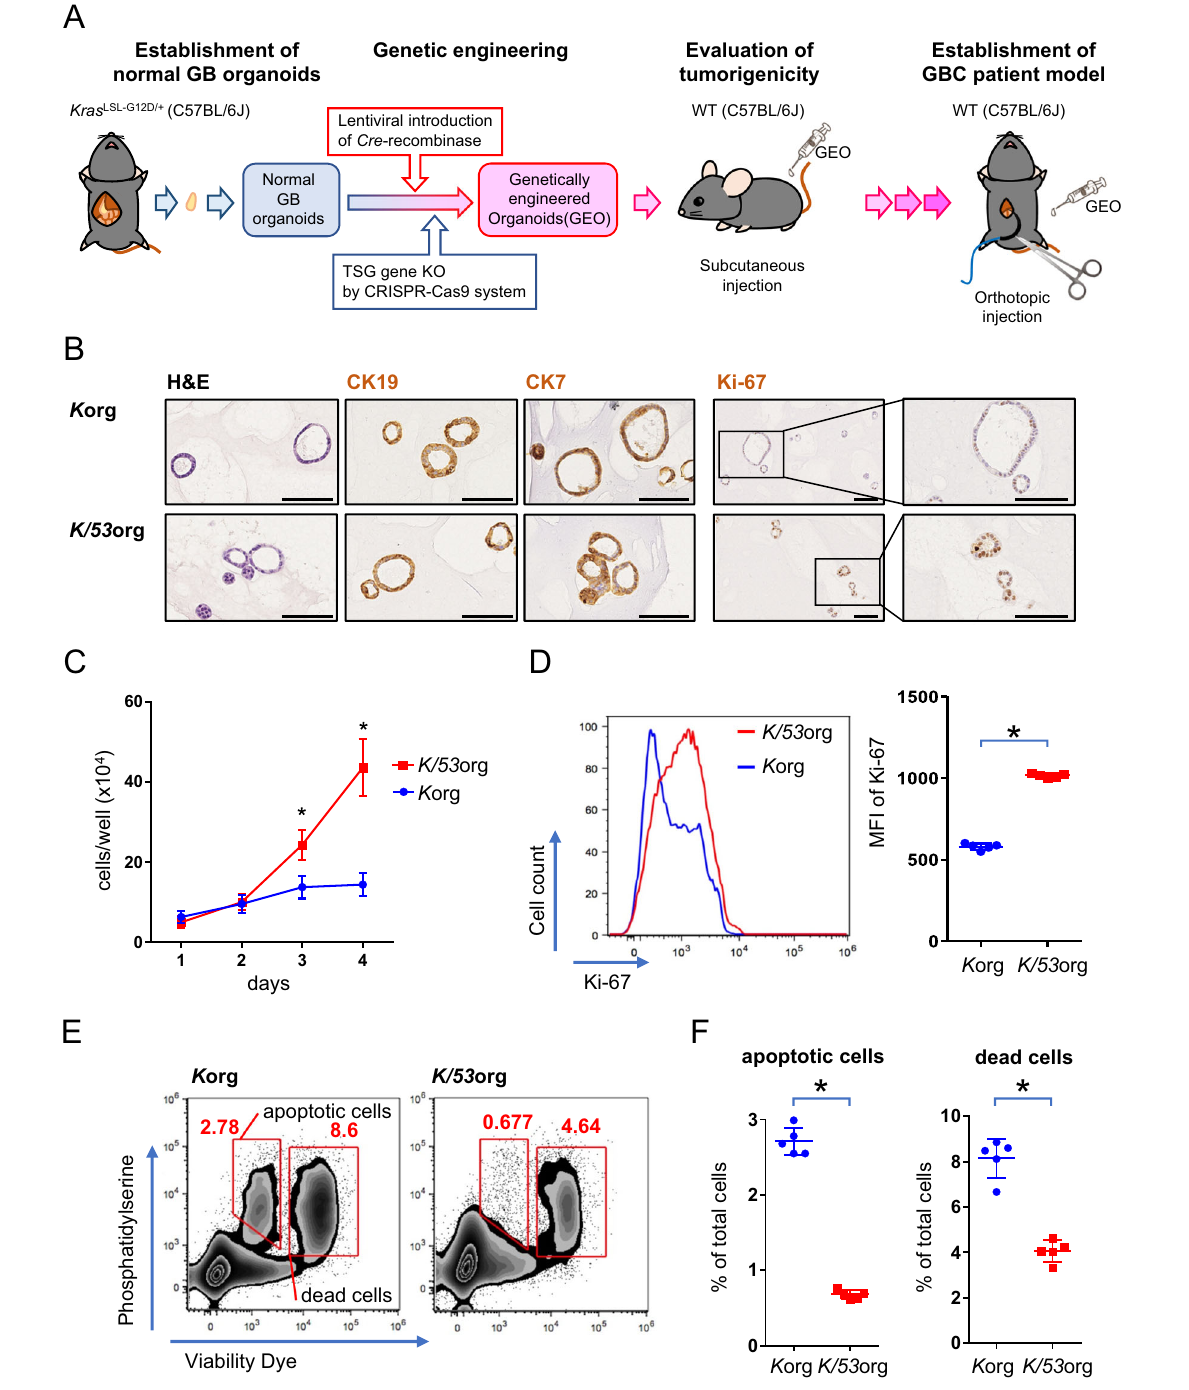
Fig. 1 Generation of murine gall bladder (GB) organoids with Kras G12D and p53 loss. A Schematic view of the experimental design. TSG tumor suppressor gene, KO knockout, WT wild type. B Immunohistochemical staining of organoids. K org, organoids expressing Kras G12D ; K/53 org, K org with Trp53 knockout. Scale bar, 100 μ m. C The proliferation rate in organoid culture. Mean cell count of six wells ± SD is shown. *, signi fi cant ( p < 0.05). D – F Flow cytometry analysis of K/53 org and K org at day 4 in C . D Ki-67 expression pro fi les. Left panel displays a representative histogram. Right panel displays a summary of the results from replicates ( n = 5). MFI median fl uorescent intensity. E Density plots of cell viability analysis. Representative images are shown. Among the phosphatidylserine high population, viability dye low fraction and viability dye high fraction were interpreted as apoptotic and dead cells, respectively. *, signi fi cant ( p < 0.05). F Summary of the results from replicates ( n = 5) in E . *, signi fi cant ( p <